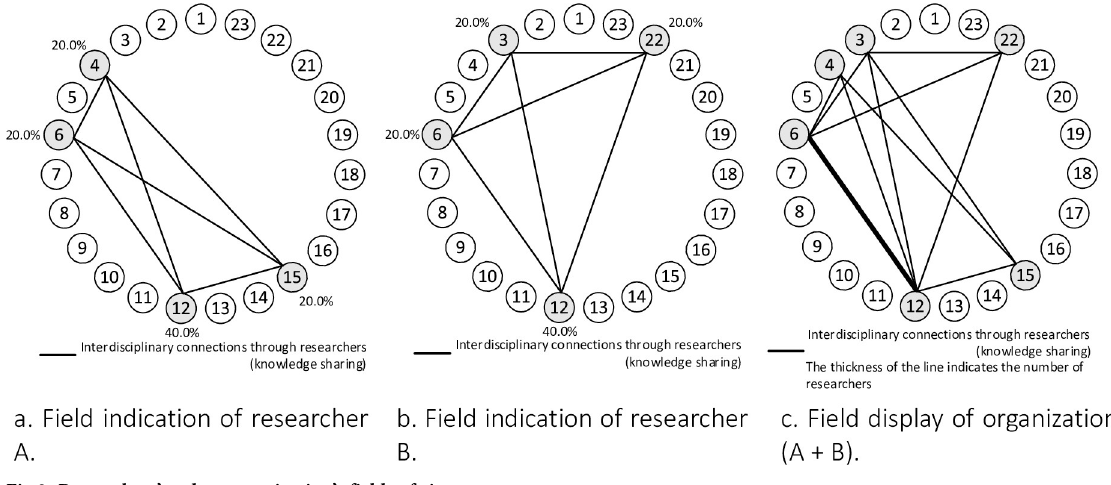
Fig 3. Researchers’ and an organization’s fields of